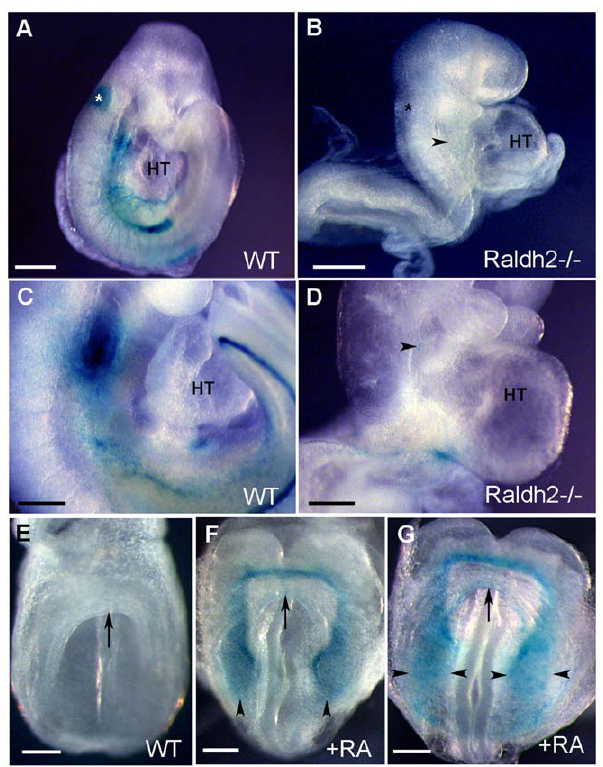
Figure 6. RA signaling affects Hoxa3-lacZ expression in transgenic embryos. Lateral views of E8.5 (A, B), E9.5 (C, D), and frontal views of E8 (E,F,G) embryos. In contrast to control Hoxa3-lacZ embryos (A, C), ß-galactosidase activity is lost in Hoxa3-lacZ / Raldh2 2 / 2 embryos (B, D). Hoxa3–lacZ embryos treated with vehicle (DMSO) show no activation of the transgene (E) whereas RA-treated transgenic embryos display a precocious ß-galactosidase upregulation in the SHF (F, G, arrowheads). Arrows (F, G) indicate the cardiac crescent. Asterisk indicates the otic vesicle. HT, heart tube. Scale bars=100 m m.